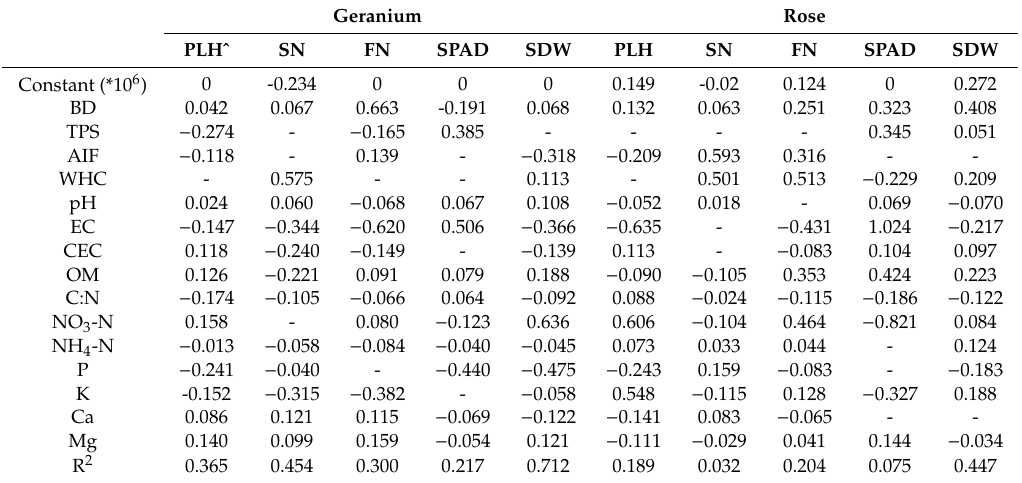
Table 6. Constant, regression coe ffi cients, and R 2 obtained by multiple regression analysis of selected geranium and rose traits. Geranium